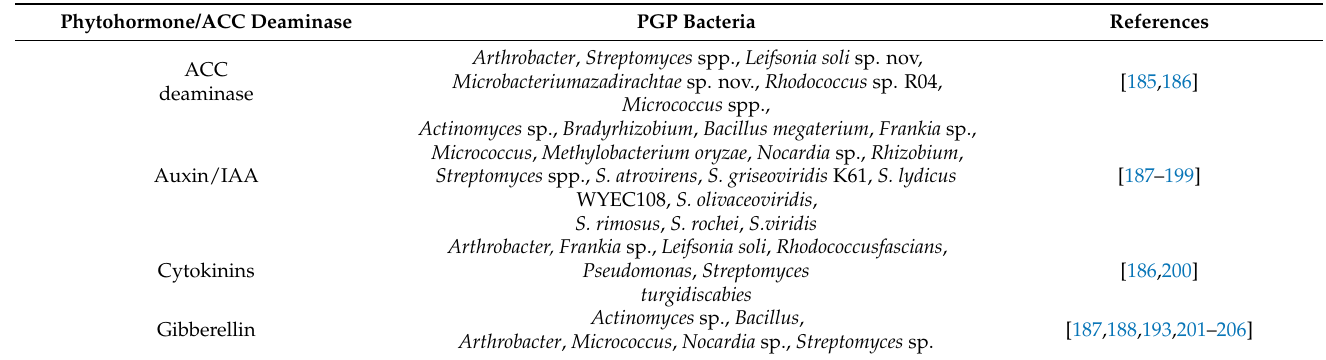
Table 2. Growth hormone-producing